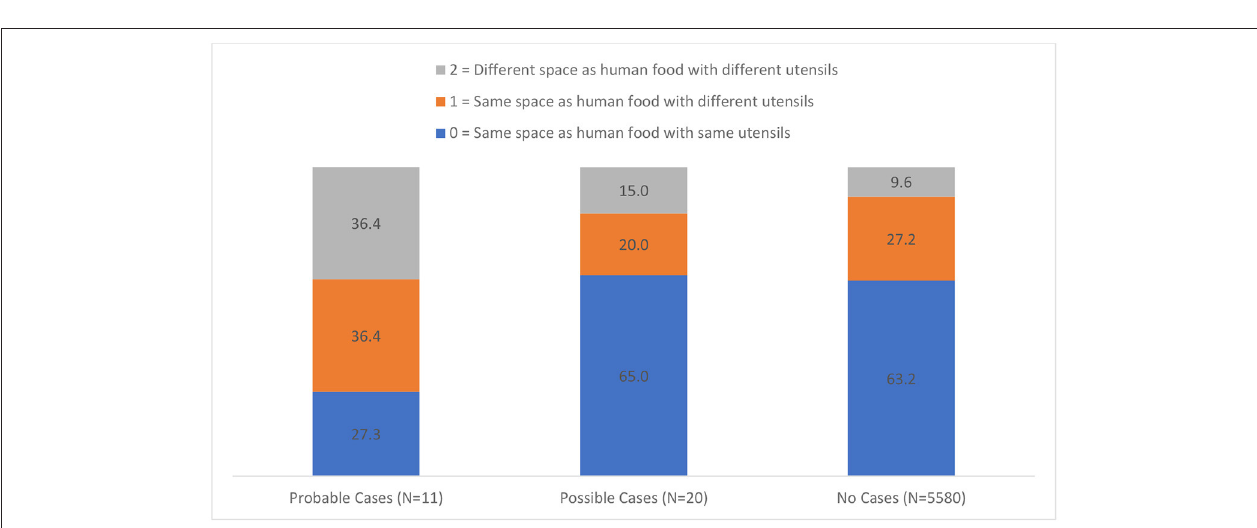
FIGURE 2 | Distribution of probable, possible and no cases of pathogens in households based on where diet was prepared and with what utensils.